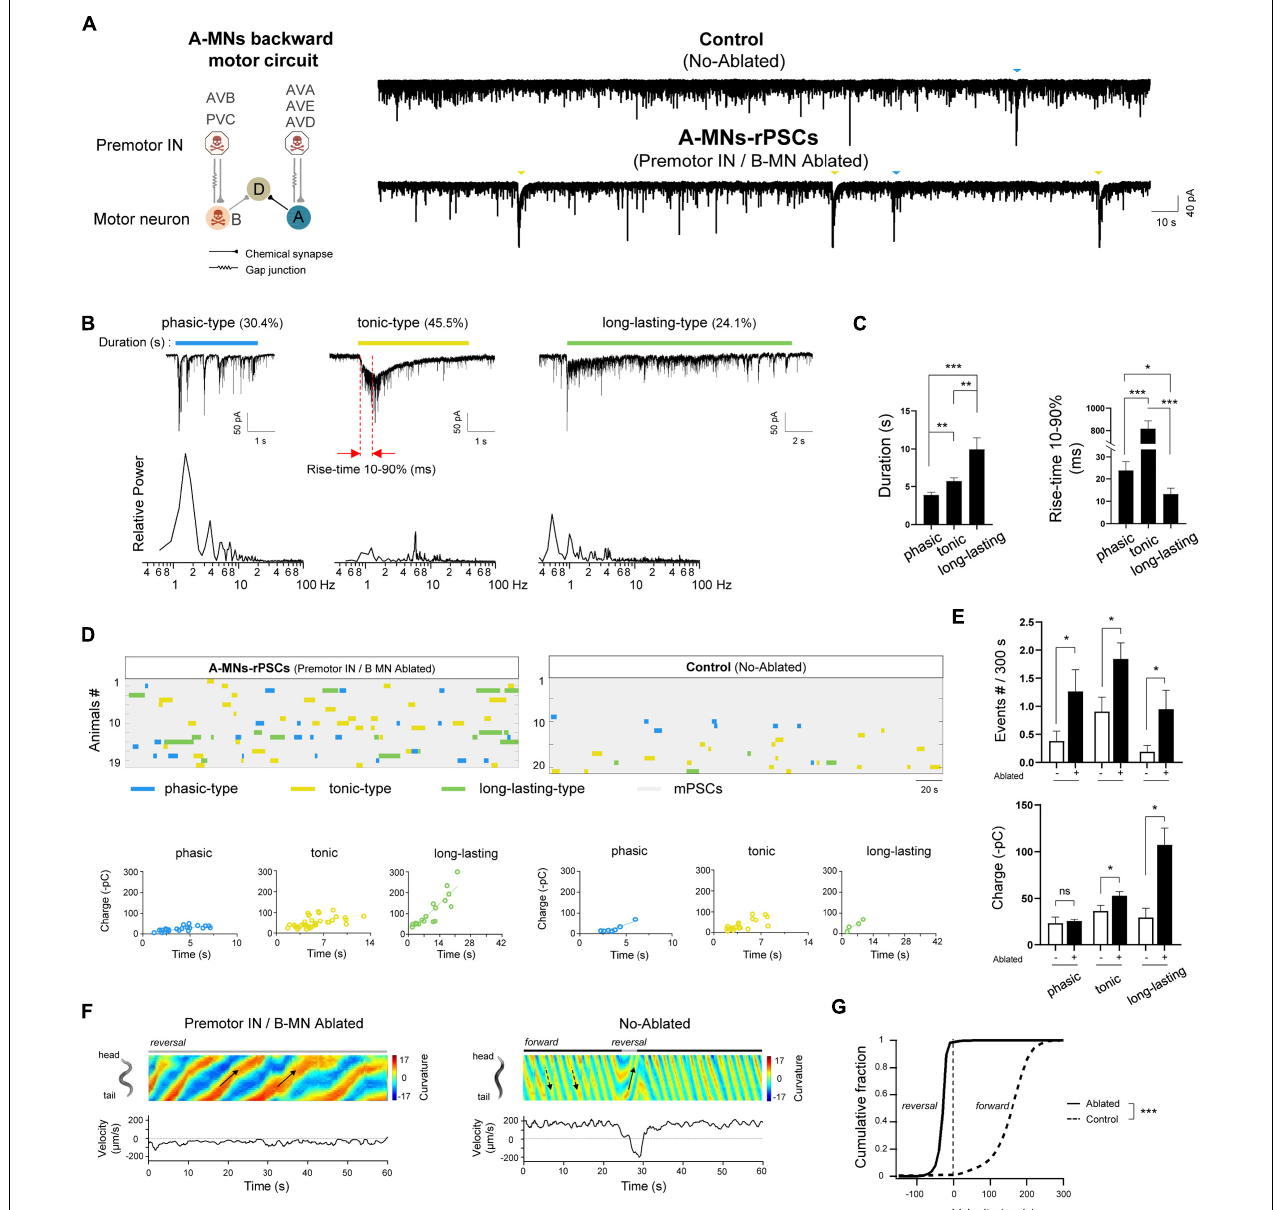
FIGURE 1 | Three types of compound rPSCs constitute A-MNs oscillators. (A) Left , schematics of the motor circuit components and connectivity. Upon ablation of premotor INs and B-MNs using miniSOG transgene animals, A-MN backward motor circuit, containing A-MNs and D-MNs, was isolated. Right , representative spontaneous PSCs trace and continue charge frequency analysis (–pC/3s) from wild-type neuromuscular junction upon the coablation of premotor INs and B-MNs. Rhythmic PSCs events with large charges were recorded. Muscle cell was held at –60 mV. (B) Top: three typical compound rPSCs exhibit distinct activation dynamics, including phasic-type, slow activated with tonic spillover PSCs (tonic-type), and fast activated long-lasting-type PSCs (long-lasting-type), respectively. Bottom: frequency spectrum analysis of above rPSCs. (C) Quantification of the duration and rise time (10–90%) of different types of events. (D) Colormap and charge efficiency (by linear fitting) of all rPSC events from the animals with (Ablated) and without (Control) ablation. Blue dots denote phasic-type events, yellow dots denote tonic-type events, and green dots denote long-lasting-type events. (E) Quantification of the frequency and charge of different rPSCs without ( − ) or with (+) premotor INs and B-MNs ablation. n ≥ 19 animals in each group. (F) Representative curvature kymogram ( up ) and instantaneous velocity ( bottom ) of free-behaving animals, with (Ablated) and without (Control) ablation. Ablated animals exhibit persistent reversal, as posterior to anterior propagating body bends (arrows). (G) Distribution of instantaneous velocity of animals with (Ablated) and without (Control) ablation. The velocity fraction is drastically left-shifted after ablation. n ≥ 10 in each group. *** p < 0.001 against non-ablated Control groups by the Kolmogorov–Smirnov test. All data are expressed as means ± SEM. Student’s t -test was used (B,C,E,F) . Statistical significance is indicated as follows: ns, not significant, * p < 0.05, ** p < 0.01, *** p < 0.001 in comparison with that as denoted.